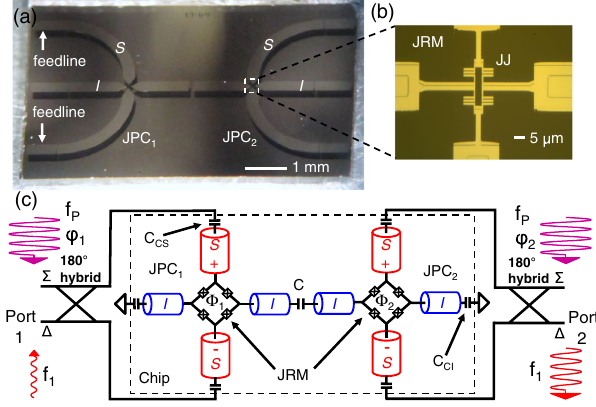
FIG. 1. (a) An optical micrograph of the device, showing two JPCs implemented back to back on the same chip and coupled through their idler resonator using a gap capacitor. The chip size is 8 : 1 mm (cid:5) 5 : 7 mm . The resonators are made of Nb over a 430 - (cid:3) m -thick sapphire substrate. (b) An optical micrograph of one of the JRMs of the device, which consists of four Al Josephson junctions. Both JRMs are flux biased Al - AlO x - near half a flux quantum using two external magnetic coils attached to the copper box housing the device. (c) A circuit representation of the two-port device. The input and output signals are fed and measured through the difference ( (cid:2) ) ports of 180 (cid:4) hybrids connected to JPC 1 and JPC 2 . The JPCs are fed with two independent pump tones at a nonresonant frequency f P . The two pumps are injected through the sum ( (cid:3) ) ports of the hybrids and excite a common mode of the JRM. The capacitors C S and I resonators to the feedlines and C CS and CI , coupling the to ground, respectively, are about 38 fF and 30 fF. In the case of the S resonators, which are accessible through external ports, this capacitance determines the external quality factor of the device. The coupling capacitor C between the two I resonators is about 20